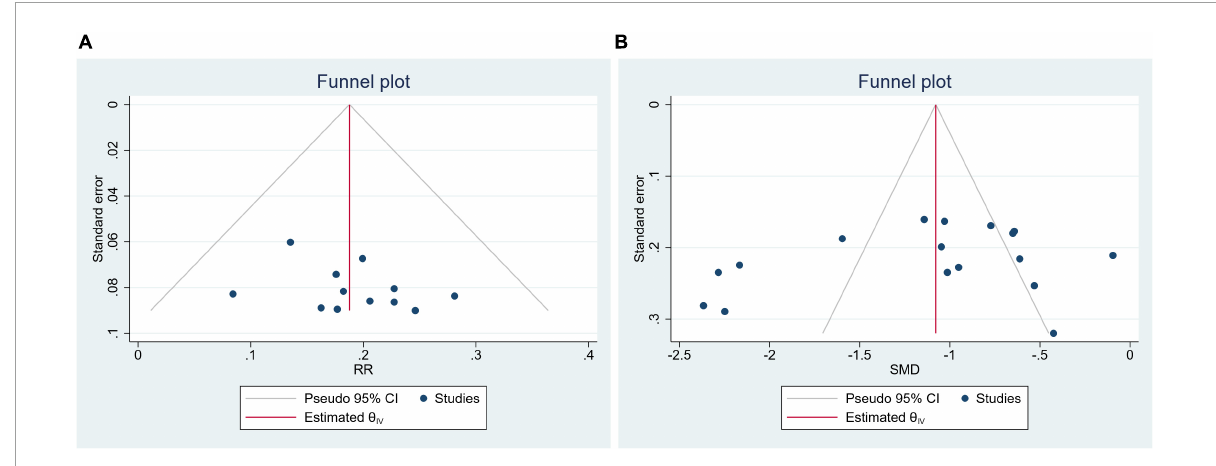
FIGURE8 Funnel plot. (A) Clinical efficacy rate; (B) systolic blood pressure.